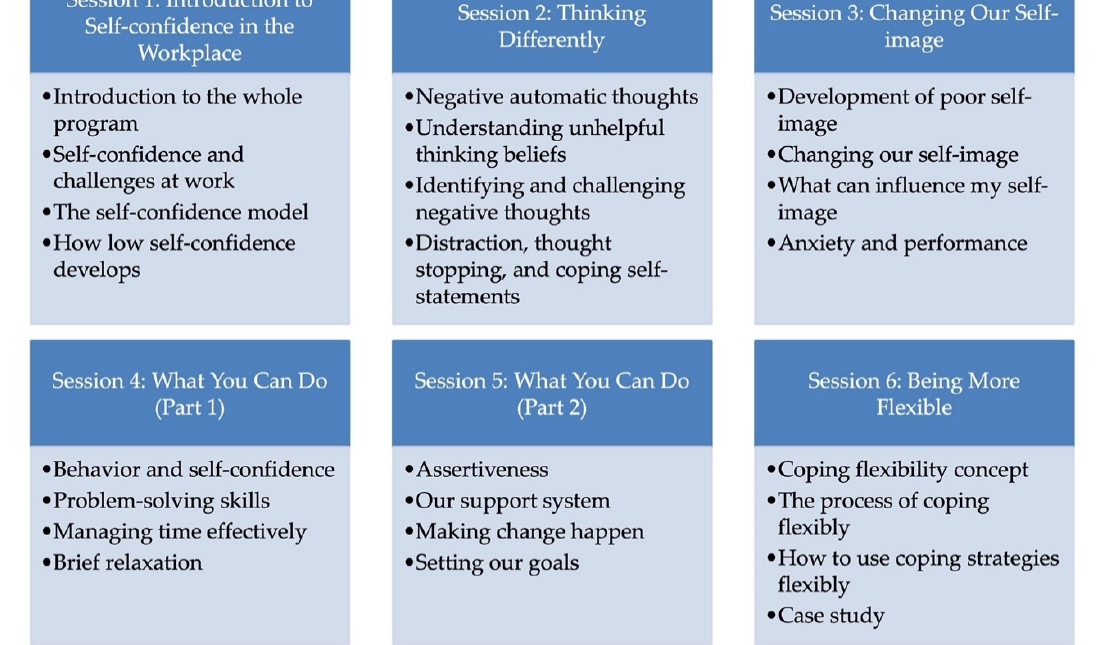
Figure 2. Summary of intervention sessions.